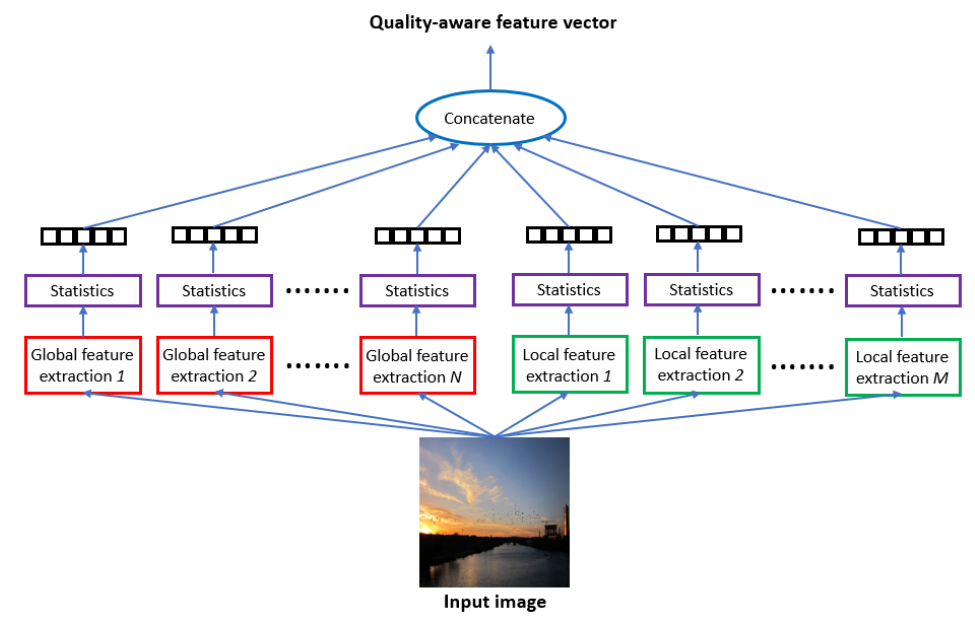
Figure 2. Process of feature extraction. To characterize an image from various points of view, different global and local feature vectors are extracted first. Next, statistics are extracted from them and fused together to avoid a long quality-aware feature